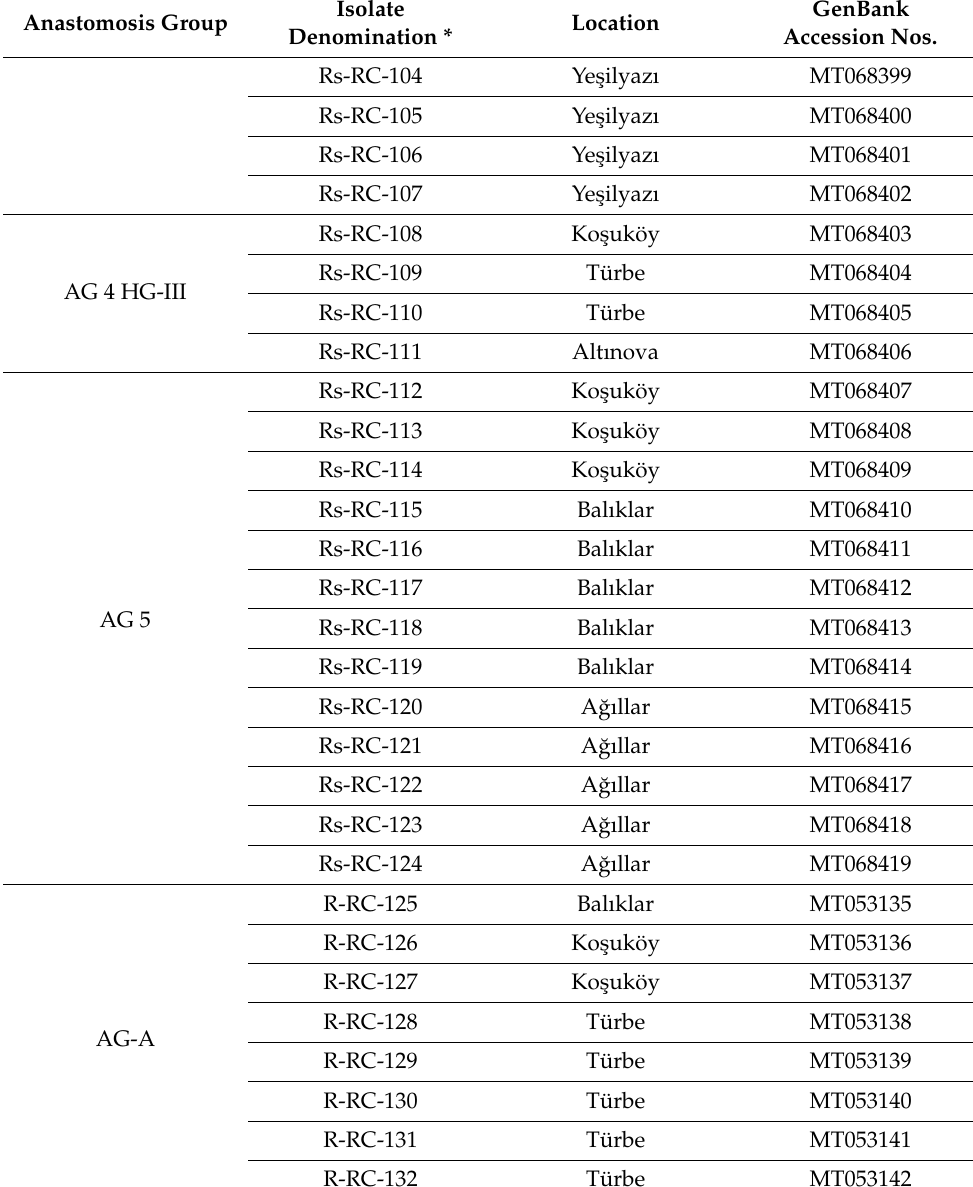
Table 2. Cont . Anastomosis Group